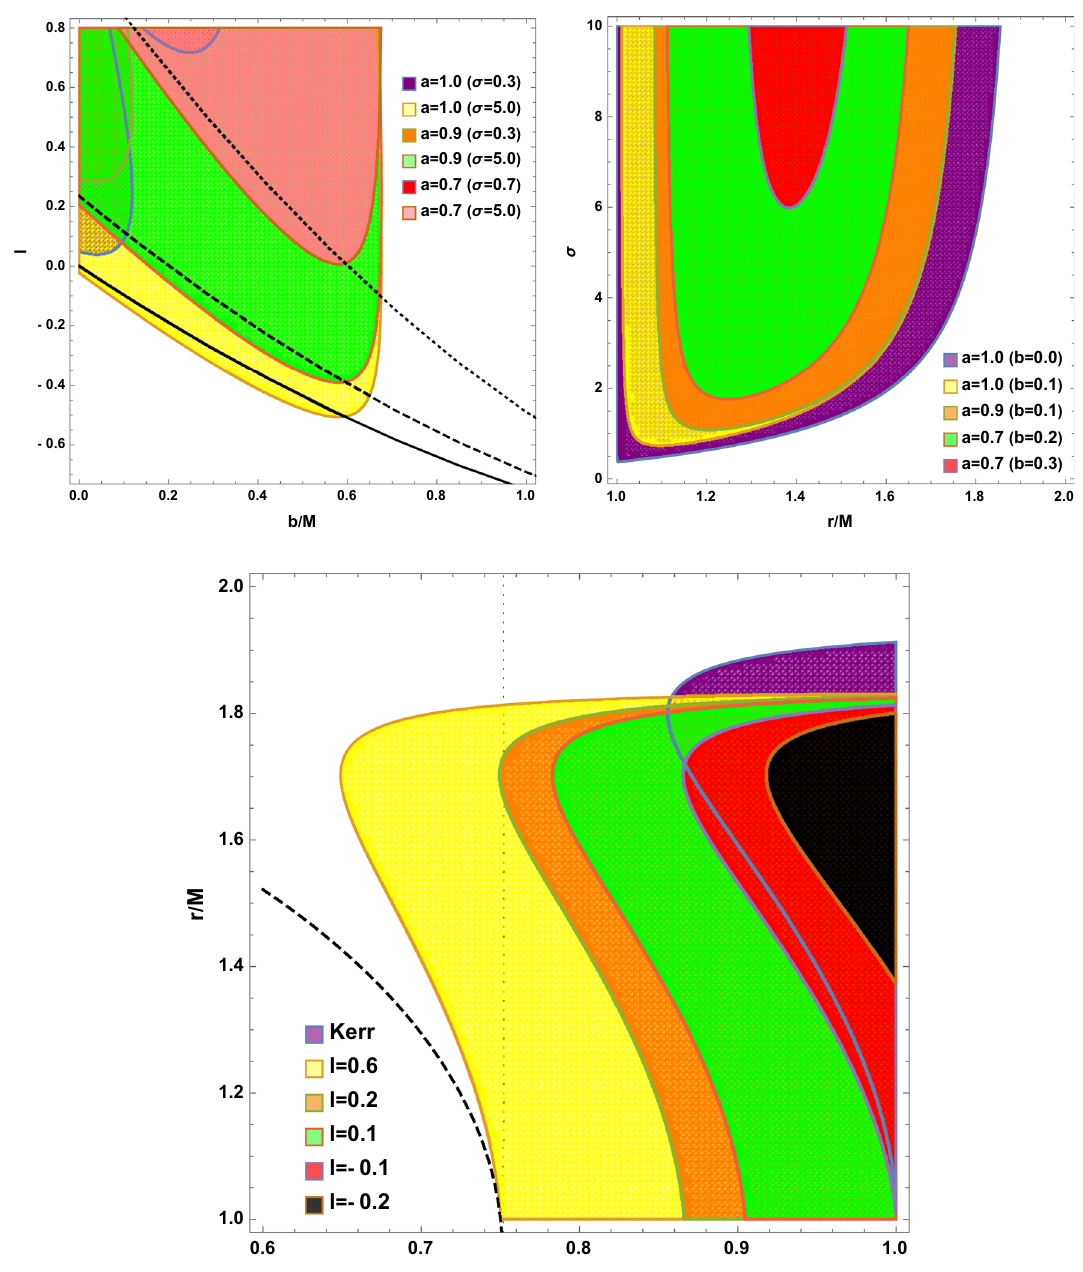
Fig. 5 (Top left) Parameter space with (cid:2) and b for different values of a and σ and with r = 1 . 2 and ξ = π/ 12 fixed. Solid, dashed and dotted curves represent existence condition of an event horizon for a = 1, a = 0 . 9 and a = 0 . 7 respectively. Only portions of regions below these curves have an event horizon, otherwise naked singularities have to be considered. As a decreases, it is necessary to increase σ 0 to have energyextraction;whileraisingtheX-pointradius r / M ,instead,shrinks regions towards positive (cid:2) and smaller b values. (Top right) Parameter space σ 0 vs r / M for different options of a , b and (cid:2) and with ξ = π/ 12 fixed. In this figure we plotted models with r ISCO < r out , which is